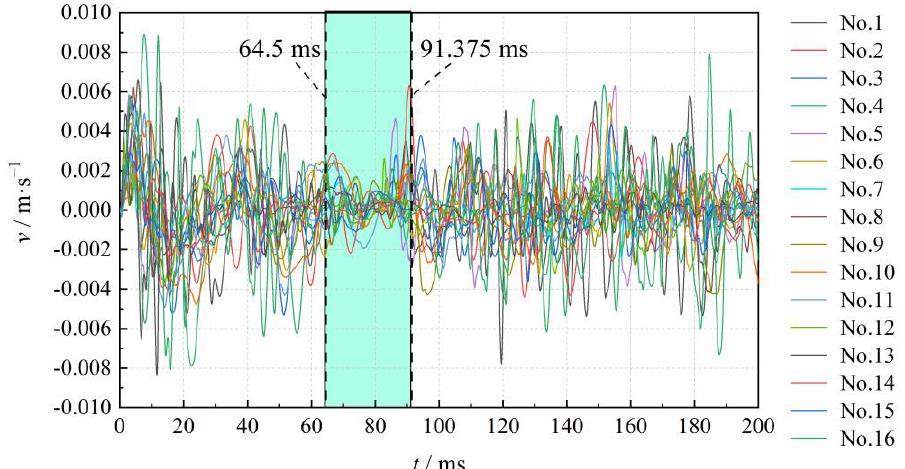
Figure 14. Vibration wave curves.